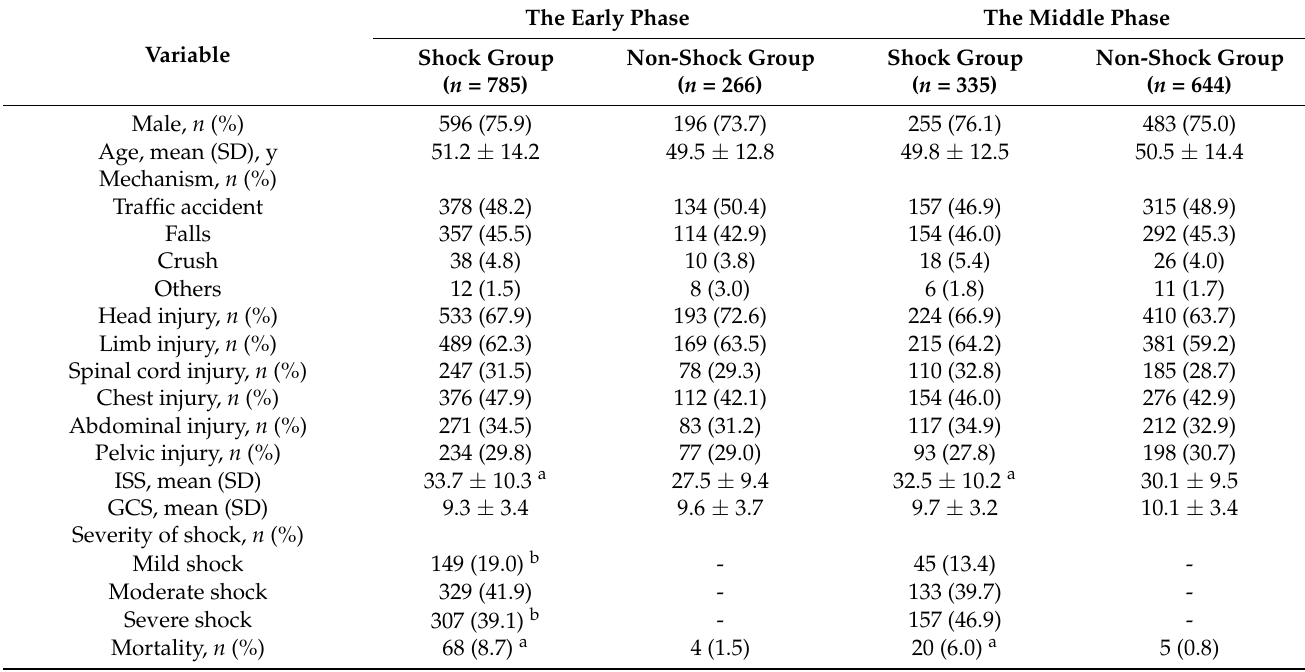
Table 2. Comparison of the shock and non-shock groups in different phases after polytrauma.